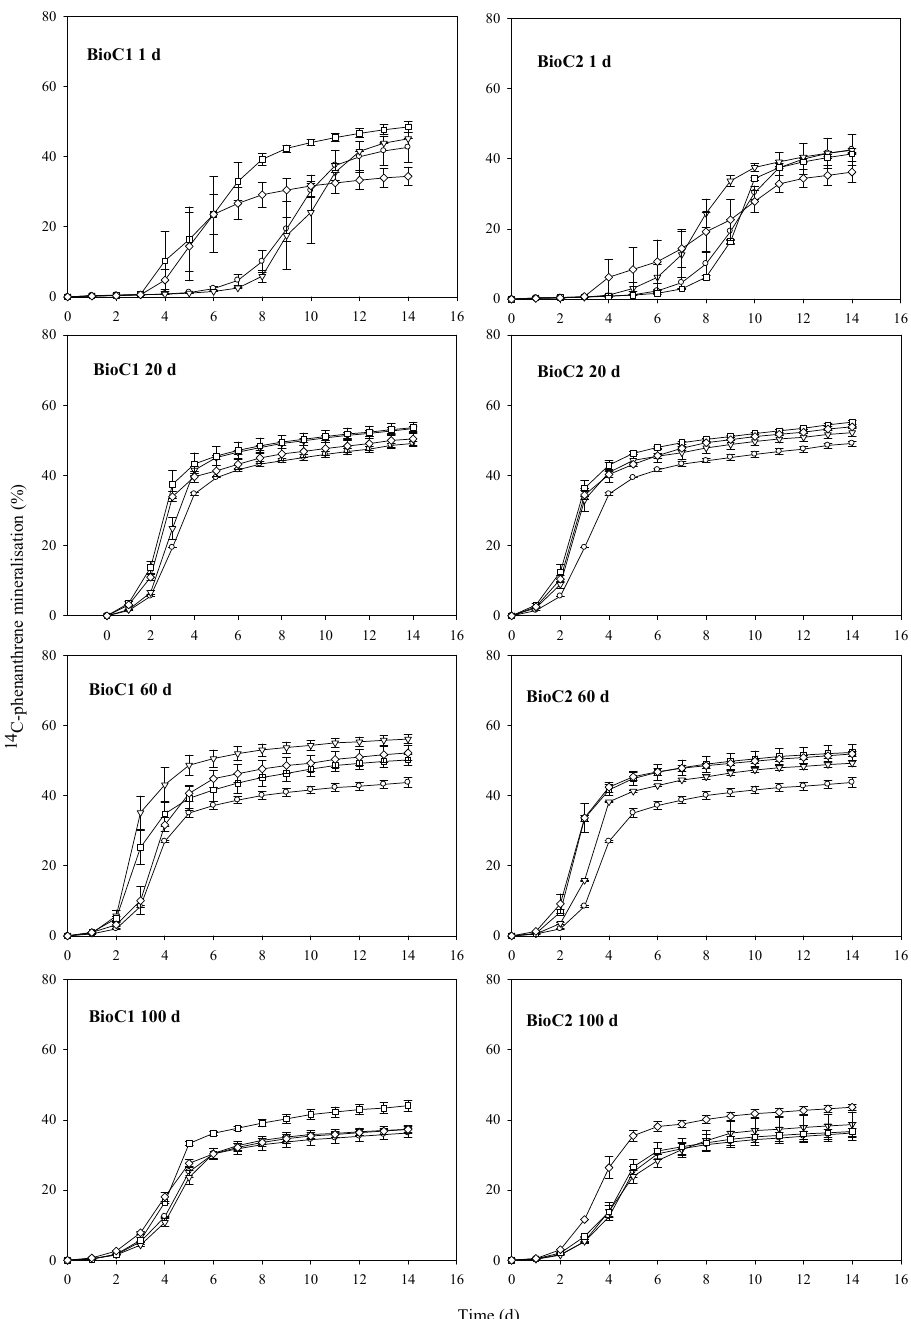
Figure 1. Mineralisation of 14 C-phenanthrene in Myerscough soil amended with biochar at 0% ( ○ ), 0.01% ( ), 0.1% ( □ ) and 1% ( ◊ ) after 1, 20, 60 and 100 d soil-phenanthrene aging periods. Error bars represent standard error of mineralisation (SEM) ( n = 3). BioC1 1